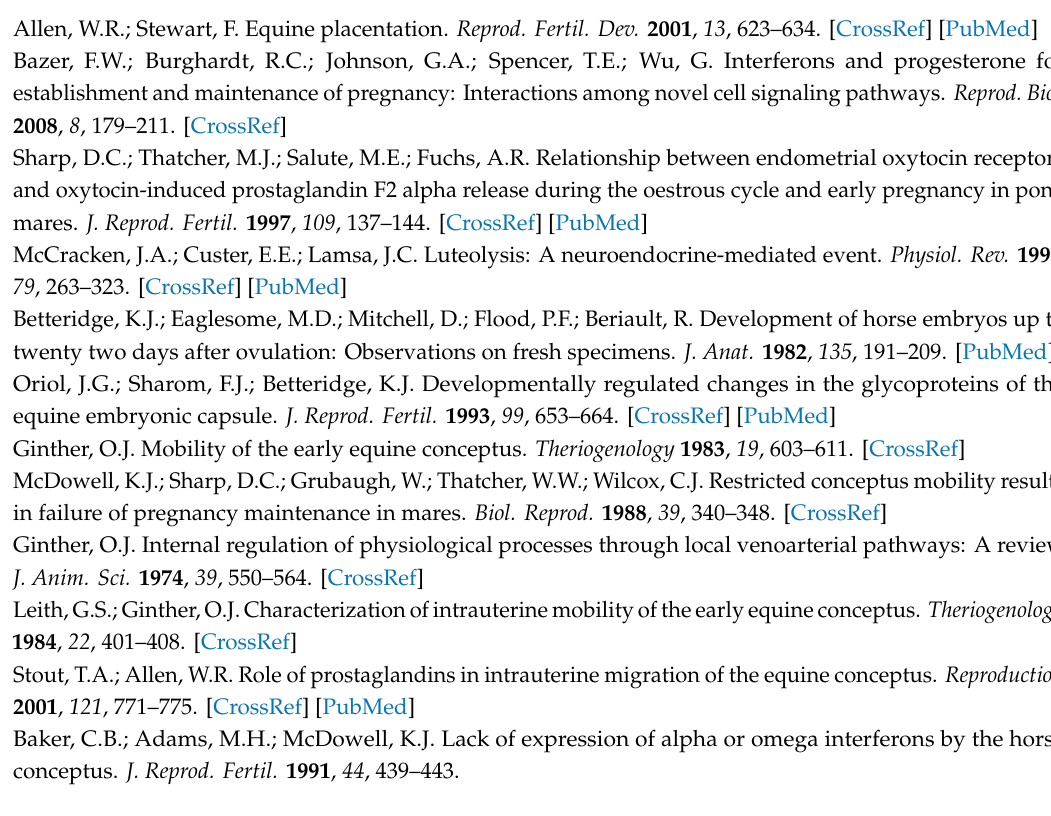
Table S1: All significant transcripts for analysis performed when reads were present in all three replicates in one of the two groups (P + or NP) on days 9, 11 and 13, Table S2: All significant transcripts ( P ≤ 0.05; annotated and unannotated transcripts) and biological pathways (for annotated transcripts) in equine endometrium from pregnant and non-pregnant mares on day 9 post-ovulation., Table S3: All significant transcripts ( P ≤ 0.05; annotated and unannotated transcripts) and biological pathways (for annotated transcripts) in equine endometrium from pregnant and non-pregnant mares on day 11 post-ovulation. Table S4: All significant transcripts ( P ≤ 0.05; annotated and unannotated transcripts) and biological pathways (for annotated transcripts. Author Contributions: Conceptualization, J.E.B., G.J.B, M.G.T., and J.F.M; data curation K.M.K., S.J.C,